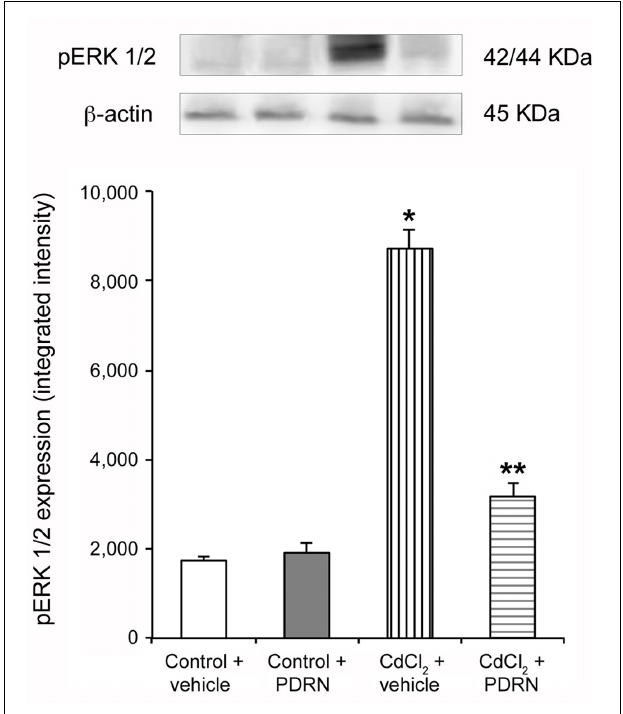
FIGURE 1 | Representative Western Blot analysis of p-ERK 1/2 of testis-derived lysates obtained from the two types of control animals (Control plus vehicle; Control plus PDRN) and the two types of treated ones (CdCl 2 plus vehicle; CdCl 2 plus PDRN). β -actin was used as an internal reference. ∗ p < 0.05 vs. controls; ∗∗ p < 0.05 vs. CdCl 2 . Bars represent the mean ± SE of seven